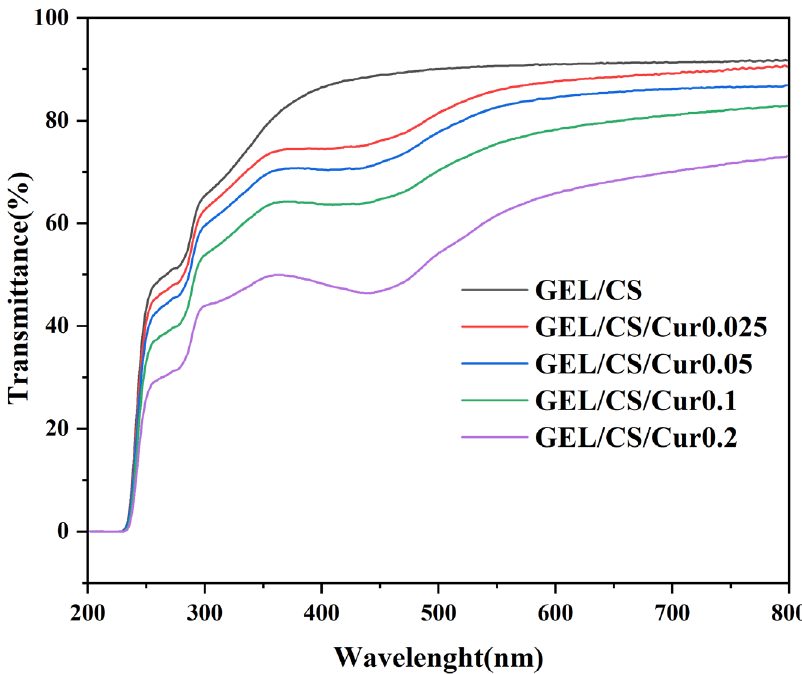
Figure 2. UV–Vis transmittance spectra of GEL/CS and GEL/CS/Cur composite films.